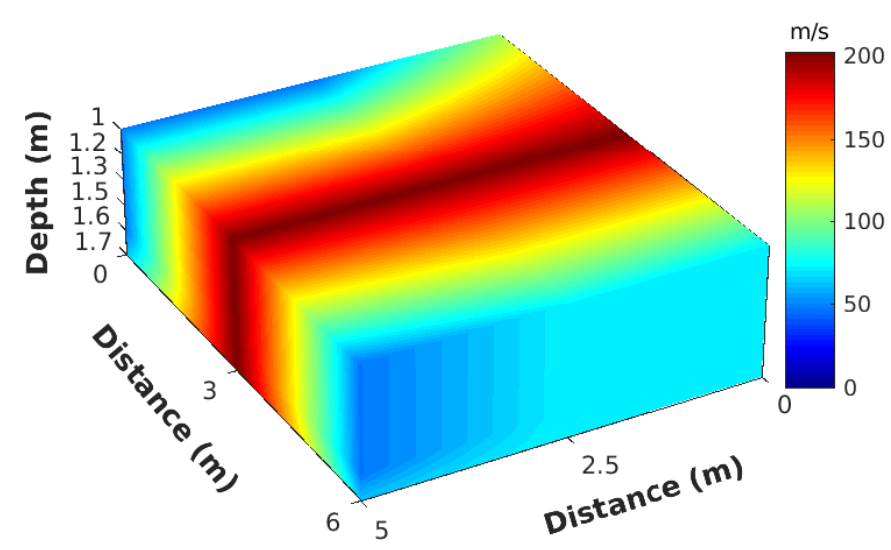
Figure 20. 3D velocity subsurface: layers between 1 and 1.7